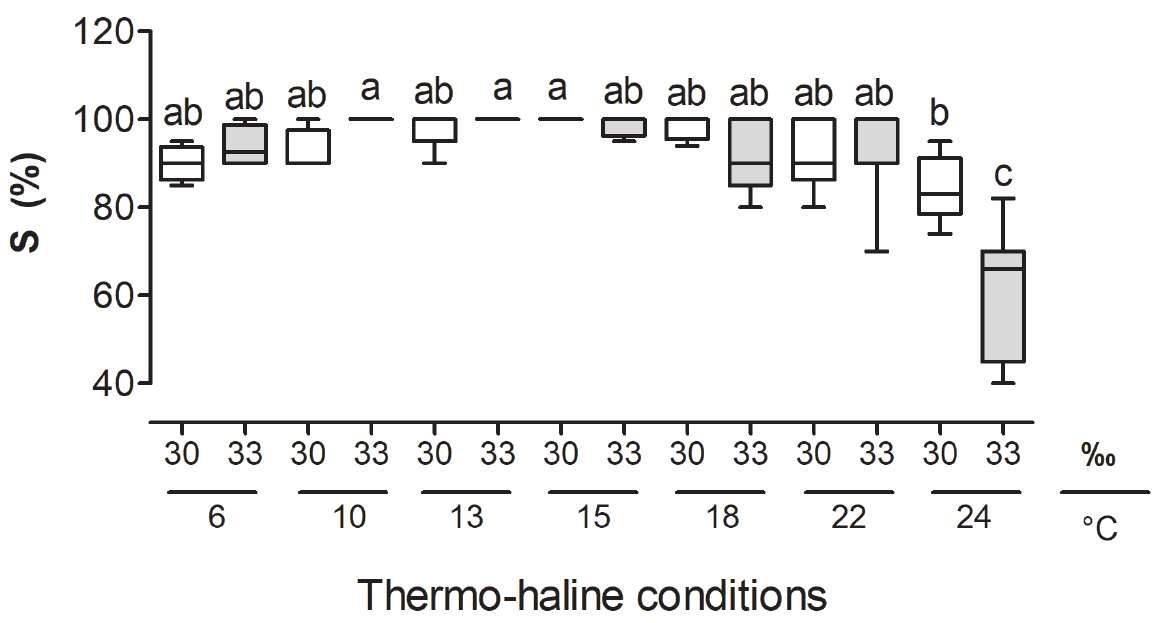
Figure 3. S urvival of Ovalipes trimaculatus embryos incubated at different seawater temperature and salinity conditions. Different letters indicate significant statistical differences between mean survival (S) in Tuckey tests. Central mark in box plots represents the mean value; upper and lower box extremes show the inter-quartile range of observed values; whiskers show maximum and minimum observed values. Shadowed boxes indicate 33‰ salinity